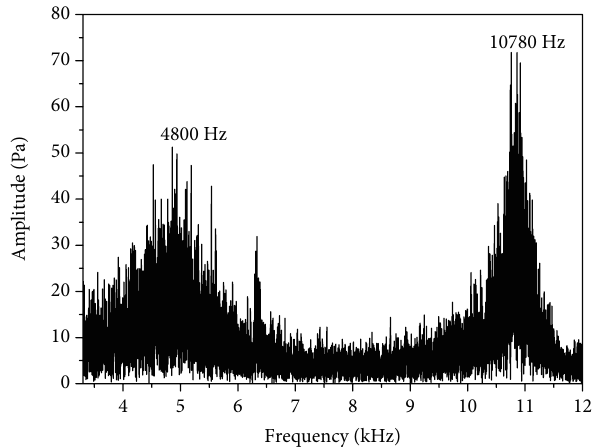
Figure 4: FFT analysis of pressure oscillations in the hot test.